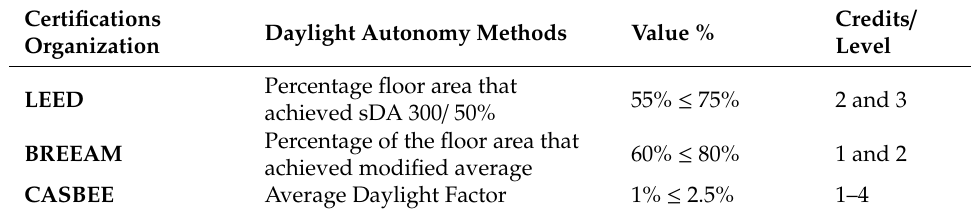
Table 3. Comparison of Certification Organizations Daylight Credit